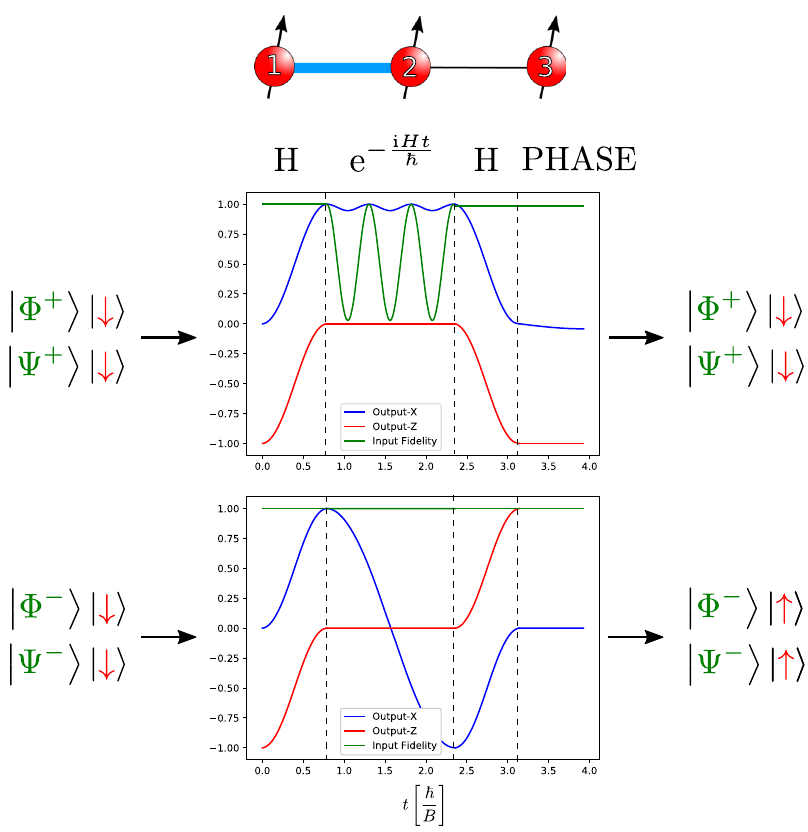
Fig. 2 Dynamics of Neuron 2. Schematic depiction of the phase-detecting neuron (top) and plots of the time-evolution of the X -component (blue) and Z -component (red) of the output-qubit state as well as the overlap between the state of the input qubits and their initial state (green) for the four Bell states during the operation of the neuron. As illustrated in these plots, the state of the output is either fl ipped or not depending on whether the input contains a positive (top) or negative (bottom) relative phase. In contrast, the input qubits return to their initial states in all four cases. Parameters used are n = 82, m = 3, which yields an average operational fi delity of 99.07% in the absence of noise. As detailed in Supplementary Note 2, small adjustments around these values can yield a slightly higher fi delity, in this case 99.58%.